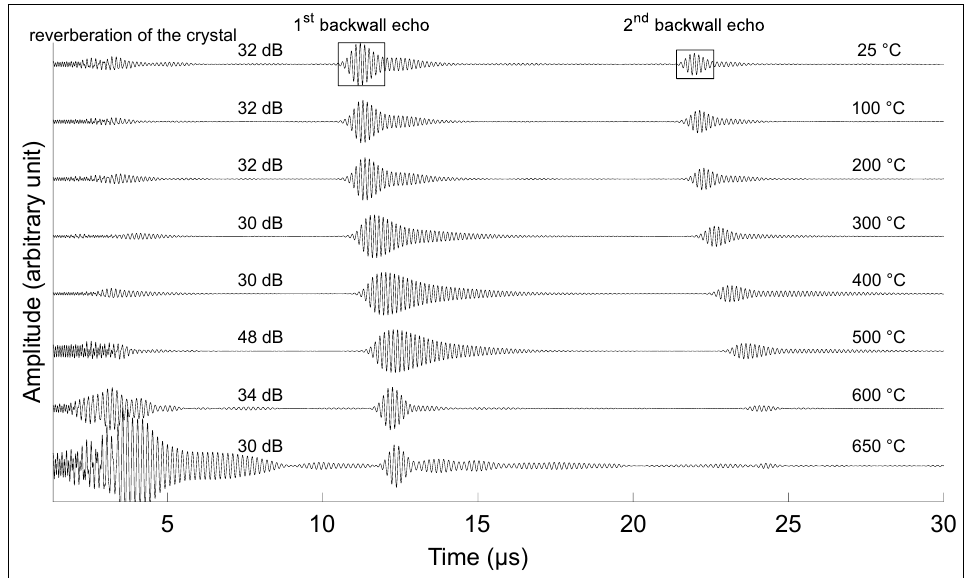
Figure 7. Signal amplitude on 32.8-mm-thick low-carbon steel block for temperatures between 25 ◦ C and 650 ◦ C, showing the first and second backwall echoes from Transducer